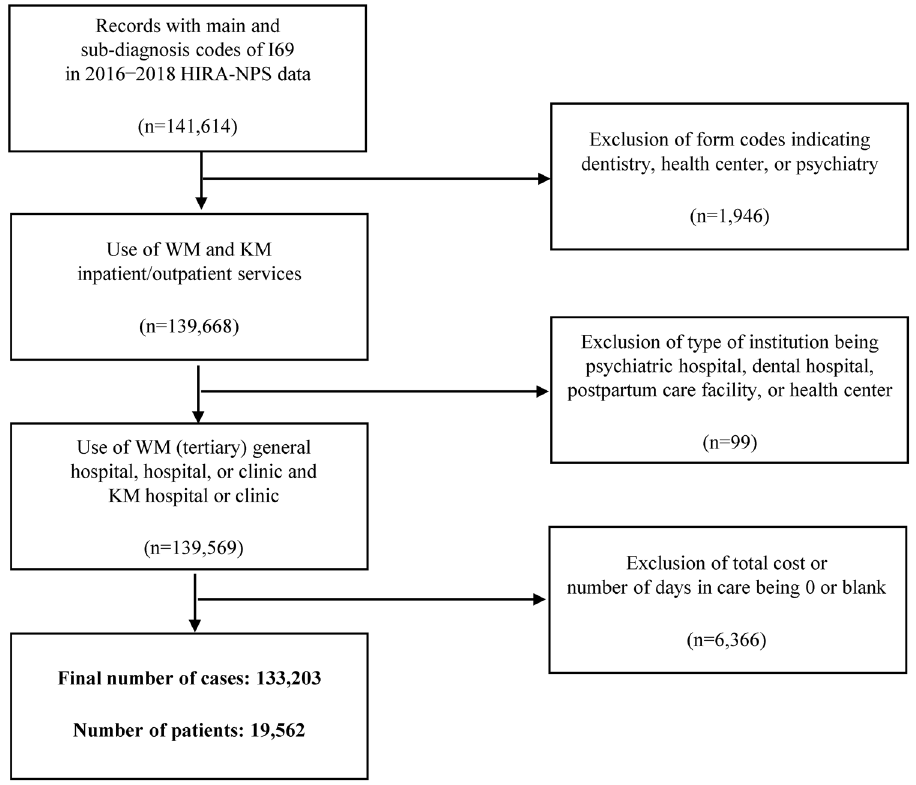
Figure 1. Flowchart of the study design. HIRA-NPS: Health Insurance Review and Assessment Service- National Patients Sample; SC: Standard care; KM: Korean medicine.